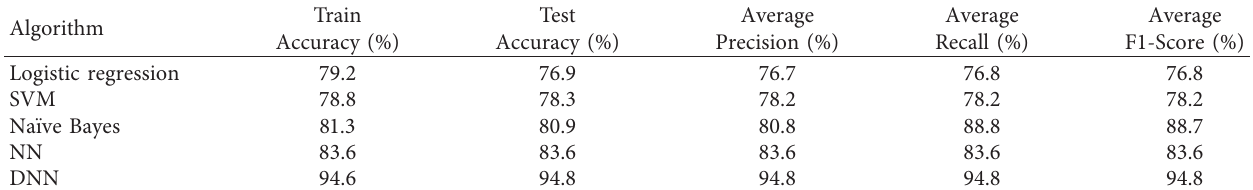
Table 3: Performance of comparison of NN and DNN with traditional machine algorithms, i.e., logistic regression, SVM, and Na¨ıve Bayes.